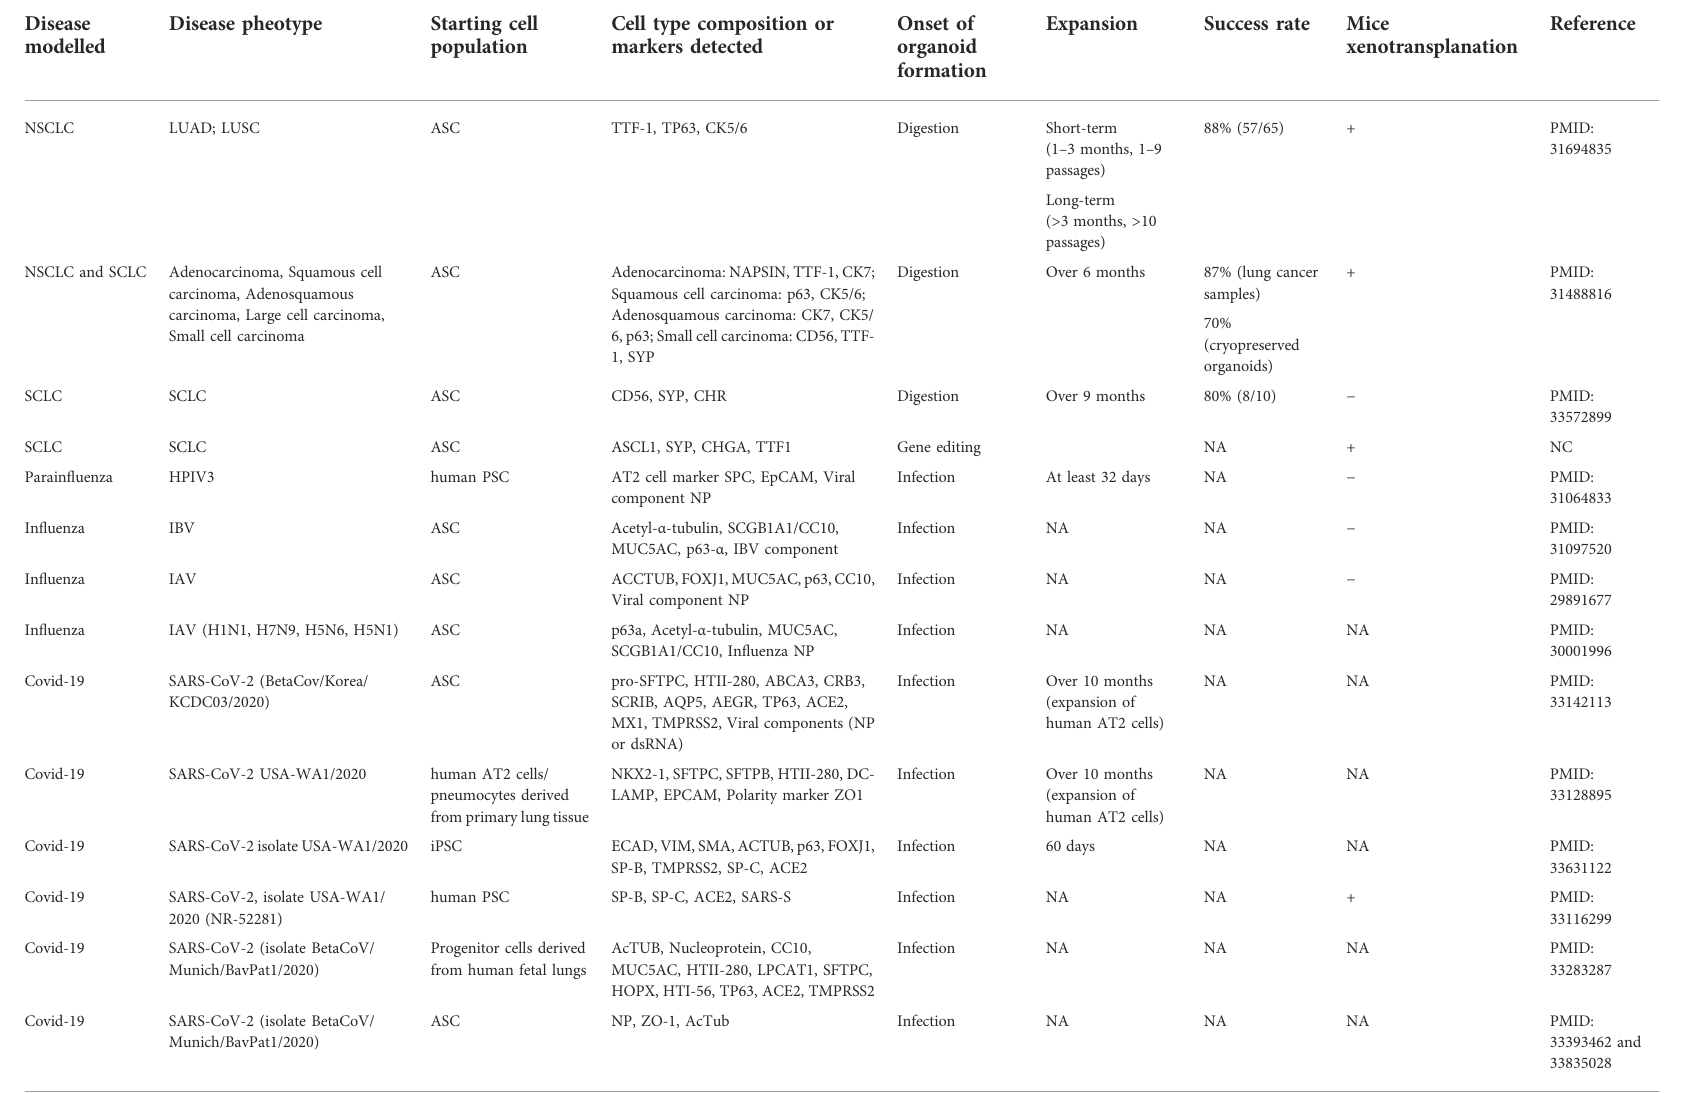
TABLE 1 Key studies of lung disease model using